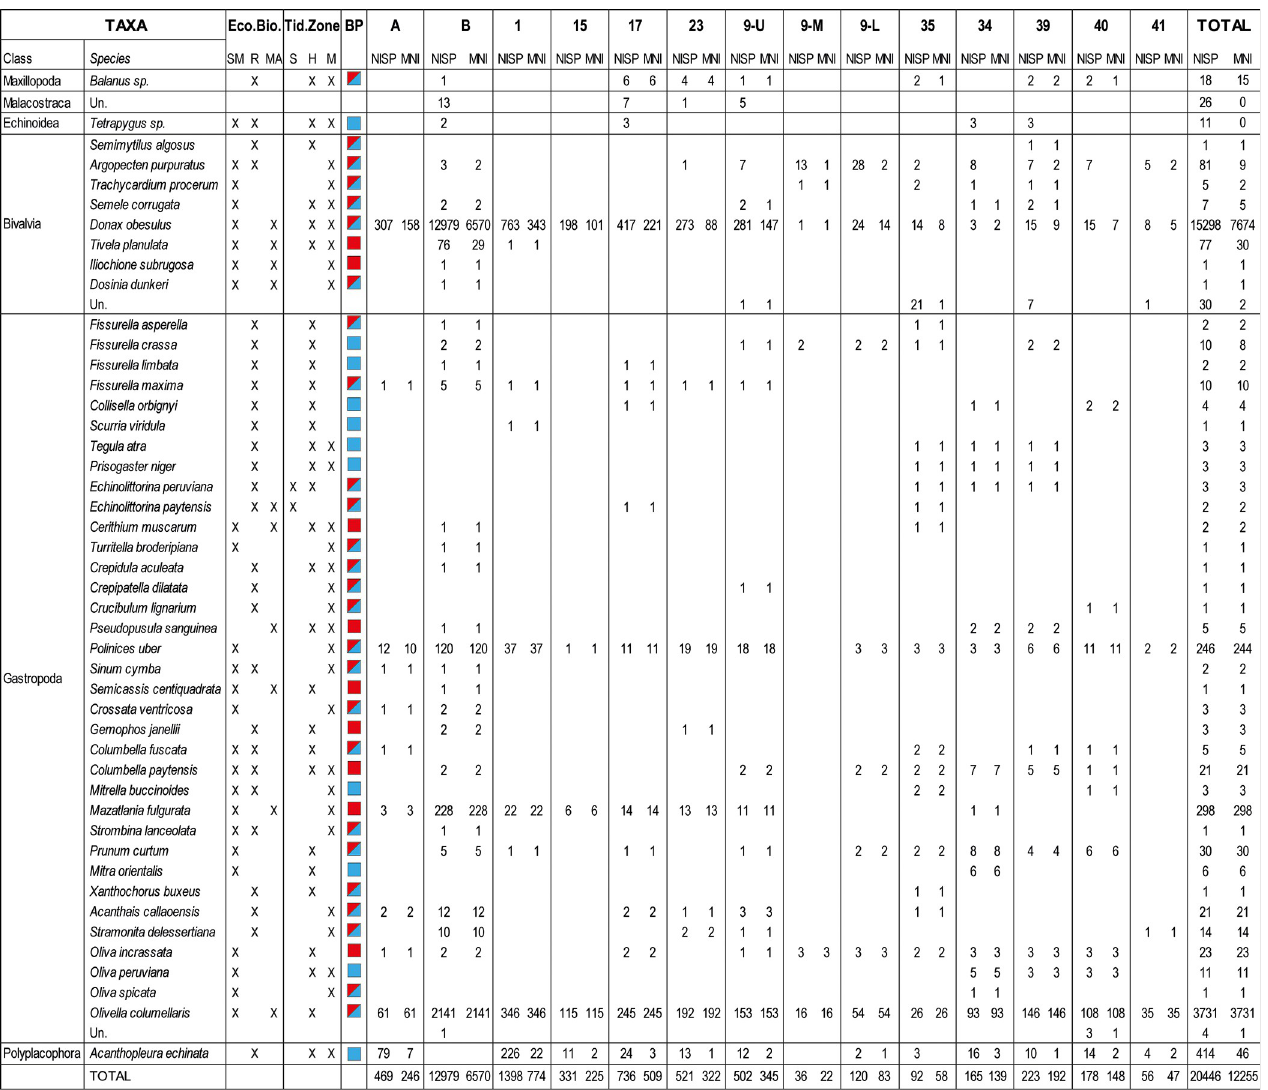
Fig 10. Huaca Grande molluscan assemblage: Ecological biotope, vertical distribution, geographic distribution, NISP and MNI of the taxa identified in trench A4.1.